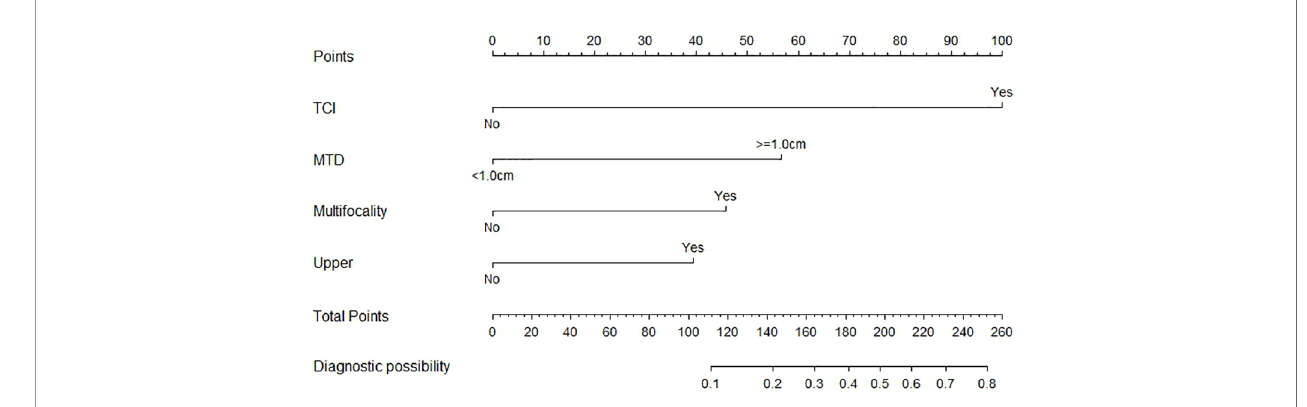
FIGURE 1 | The nomogram for predicting risk of skip metastasis in PTC